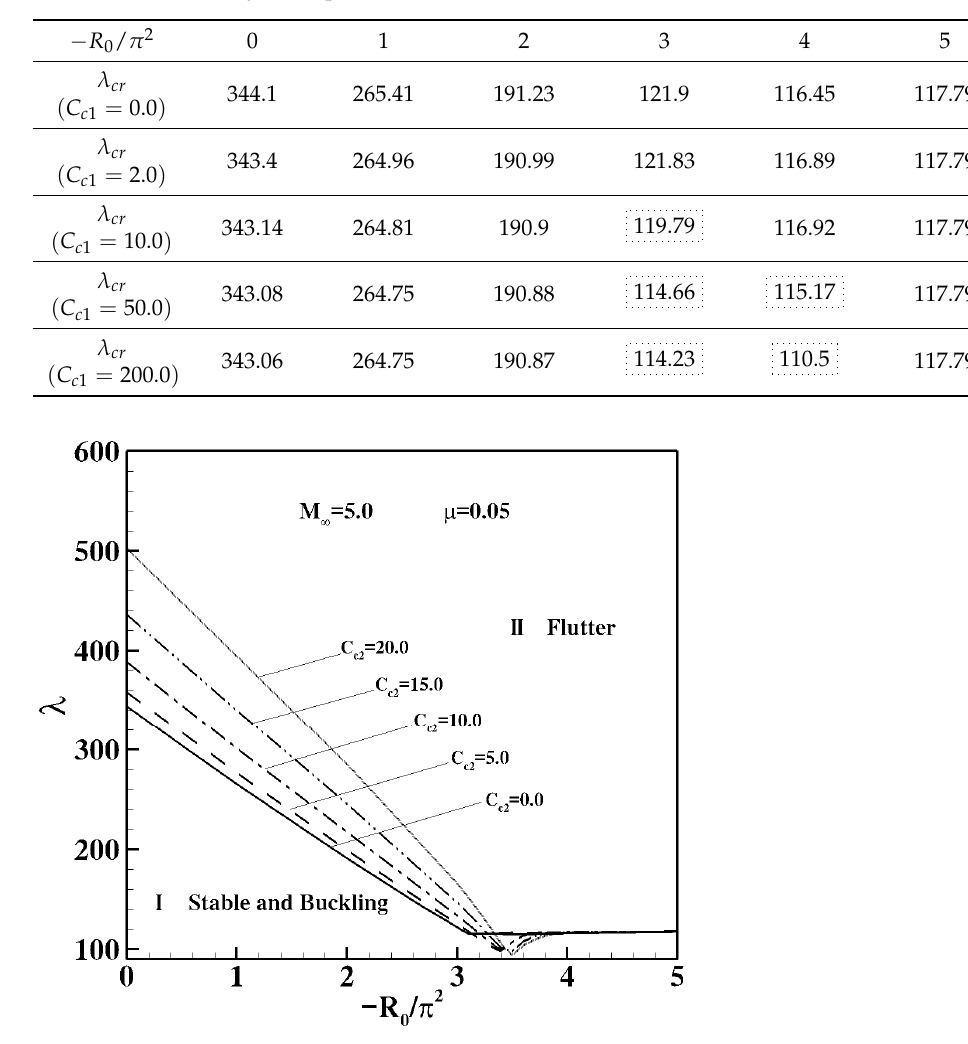
Figure 18. Stability regions under different viscous resistances. In this section, the stability characteristics of the panel under the action of coolant are presented. The pressure drop ratio with a range of ( 1, ∞ ) determines the pressure difference distribution on the surfaces of the panel. The critical dynamic pressure under a low pressure drop ratio is larger than that under a high pressure drop ratio. The coefficient of head-panel pressure determines the magnitude of pressure difference. The critical dynamic pressure is large when the coefficient of head-panel pressure is valued far